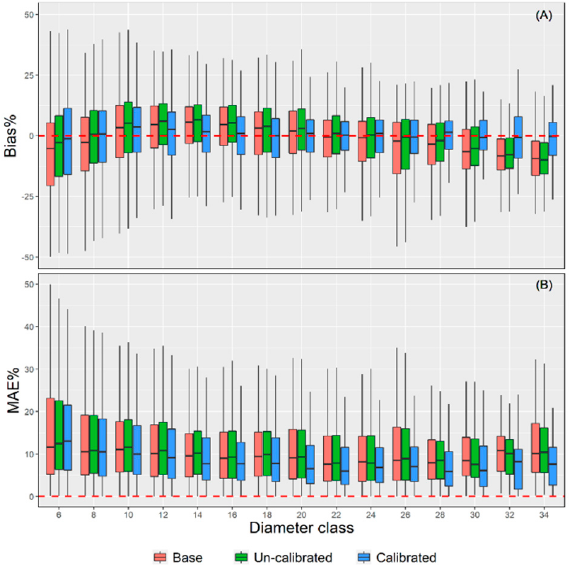
Figure 5. The boxplots of Bias% ( A ) and MAE% ( B ) of the three models across 15 diameter classes.